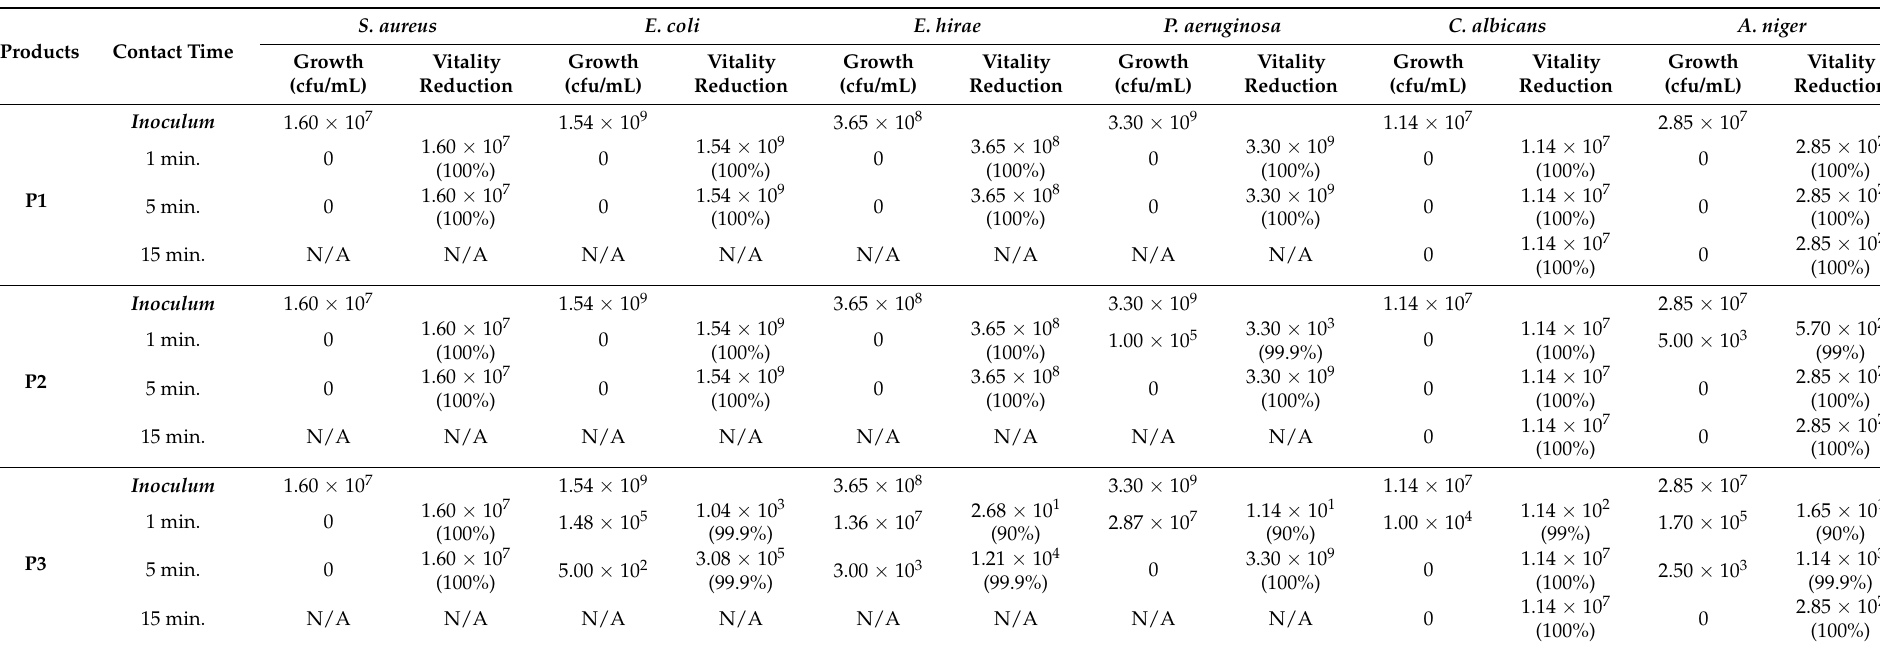
Table 2. Biocide efficacy for P1, P2, P3 after 1, 5, and 15 min of contact with the pathogen. Every result is calculated as the mean of the counts of two